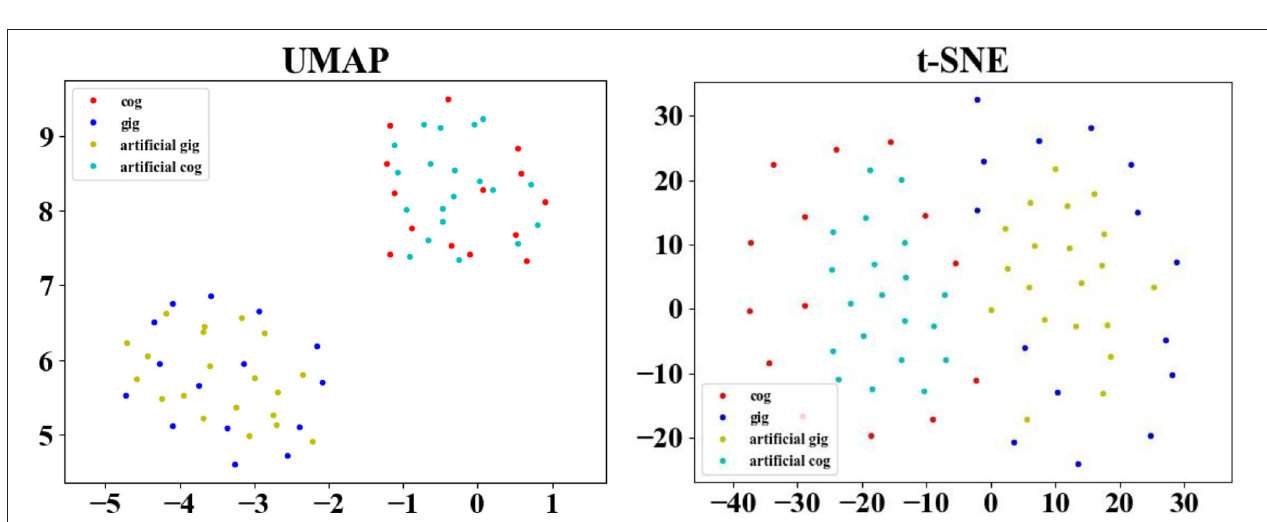
FIGURE 10 | Feature map of the artificial gifted group (artificial gig), artificial control group (artificial cog), original gifted group (gig), and original control group (cog) plotted with